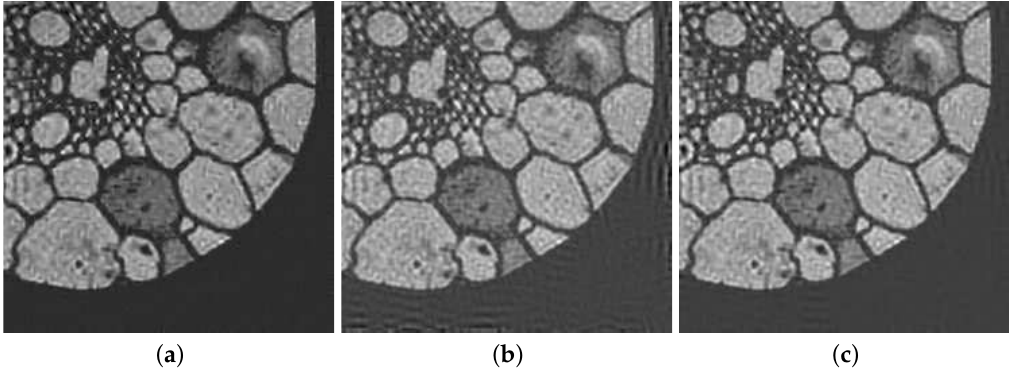
Figure 6. Grain test problem reconstructions: ( a ) ISTA, ( b ) PISTA Λ , ( c ) Struct-PISTA Λ